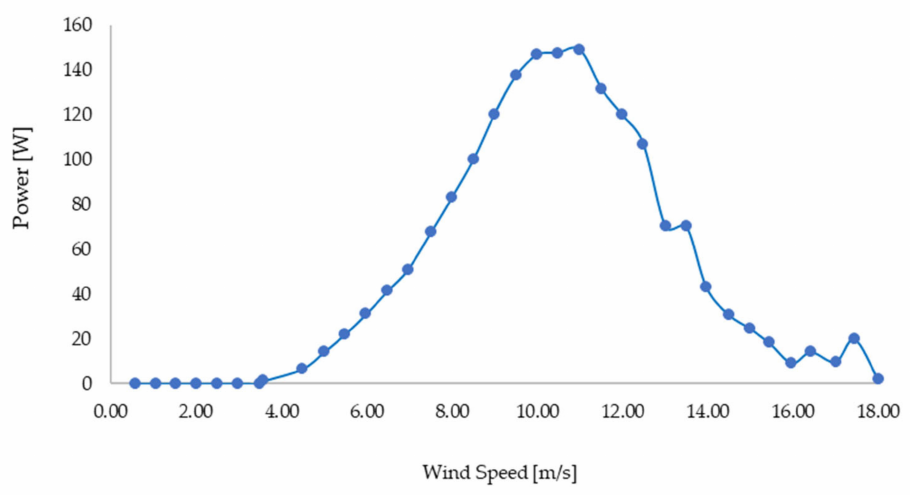
Figure 4. The DG system component (wind